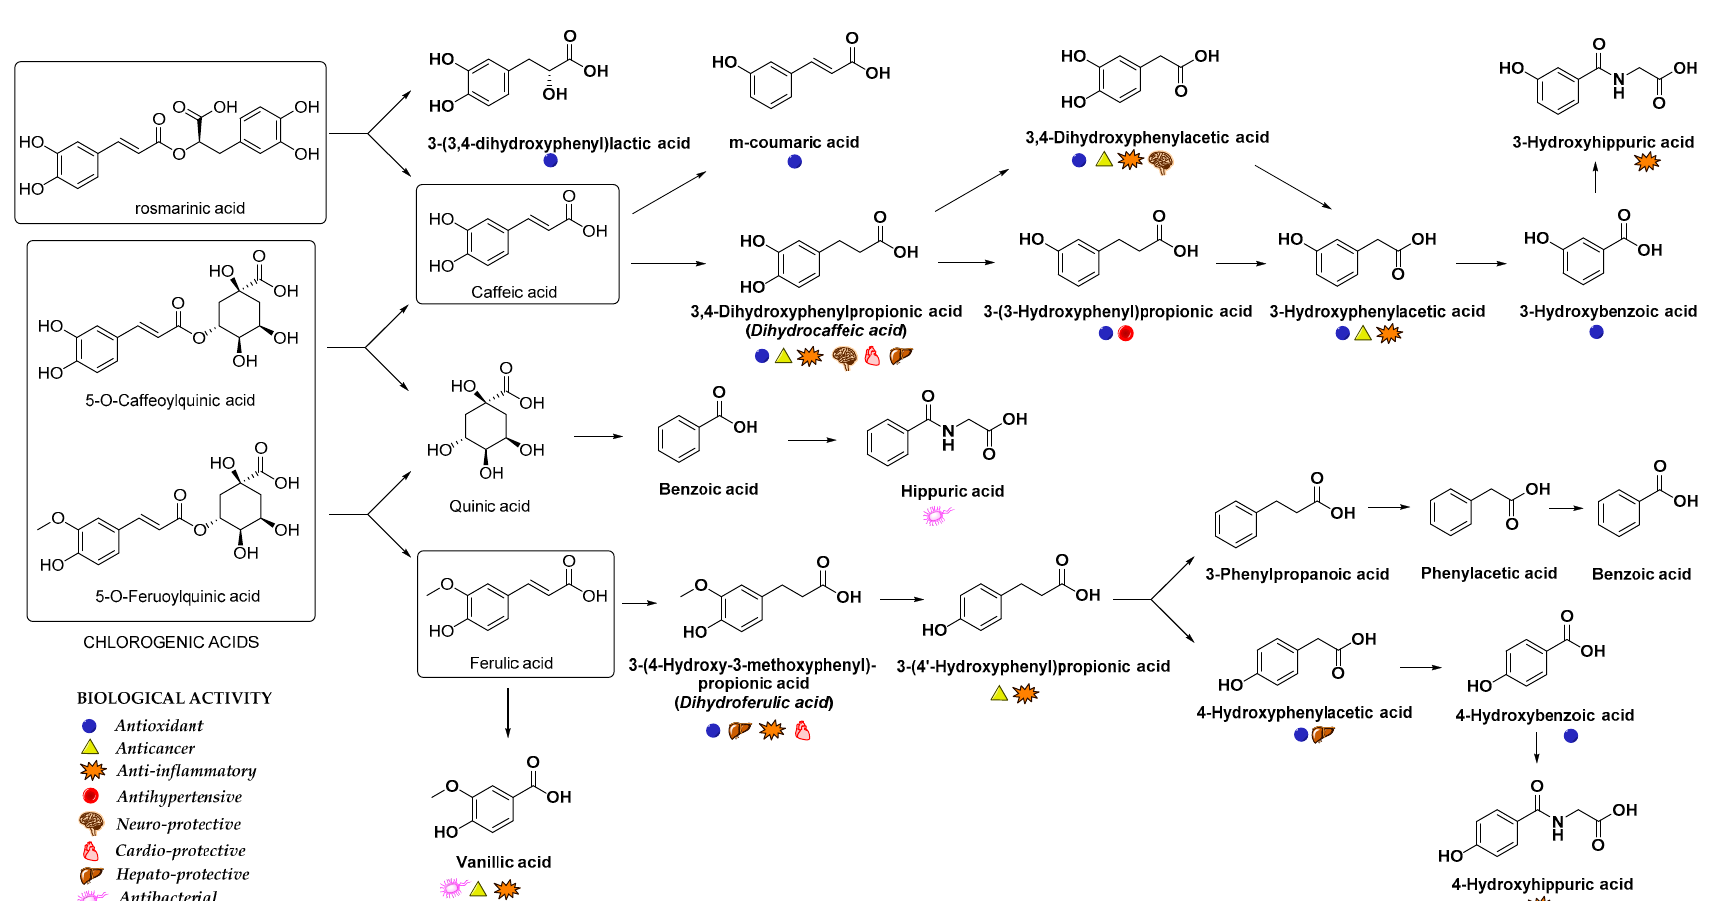
Figure 4. Main metabolites of rosmarinic, chlorogenic, caffeic and ferulic acids that appeared after biotransformation by gut microflora [67,75,88,89]. The main biological activities of selected metabolites are presented with appropriate symbols.